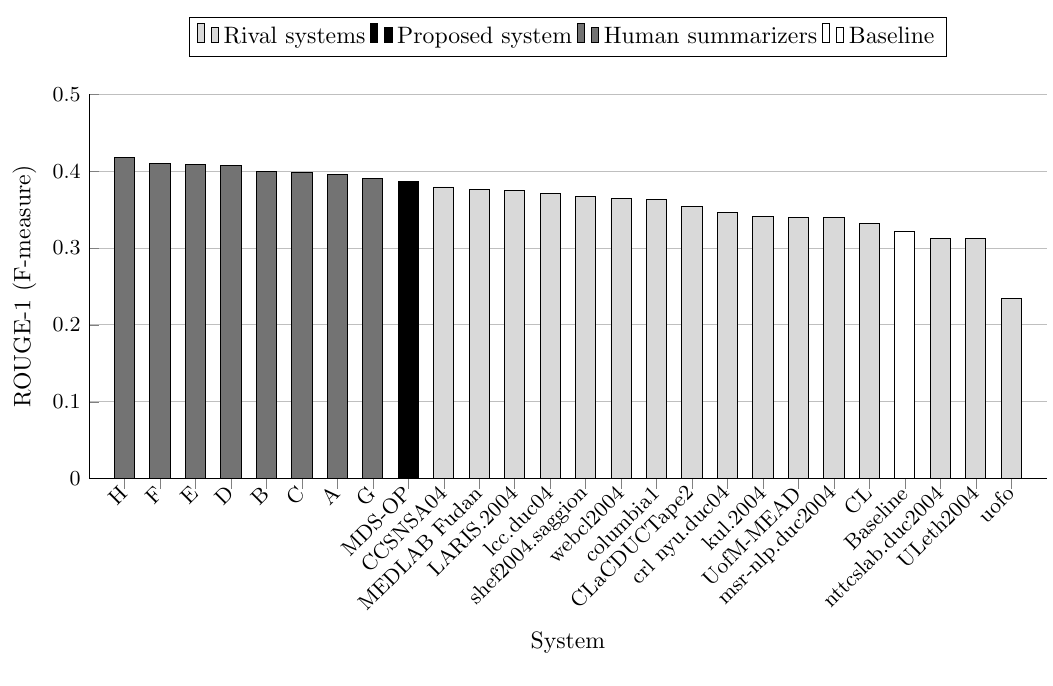
Figure 3. ROUGE-1 scores (F-measure) on DUC 2004 (Task 2).